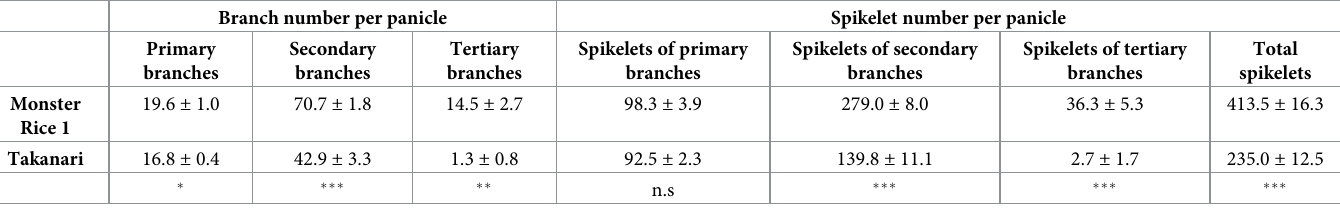
Table 3. Comparisons of branch and spikelet number per panicle in the main culm between Monster Rice 1 and Takanari in 2017. Branch number per panicle